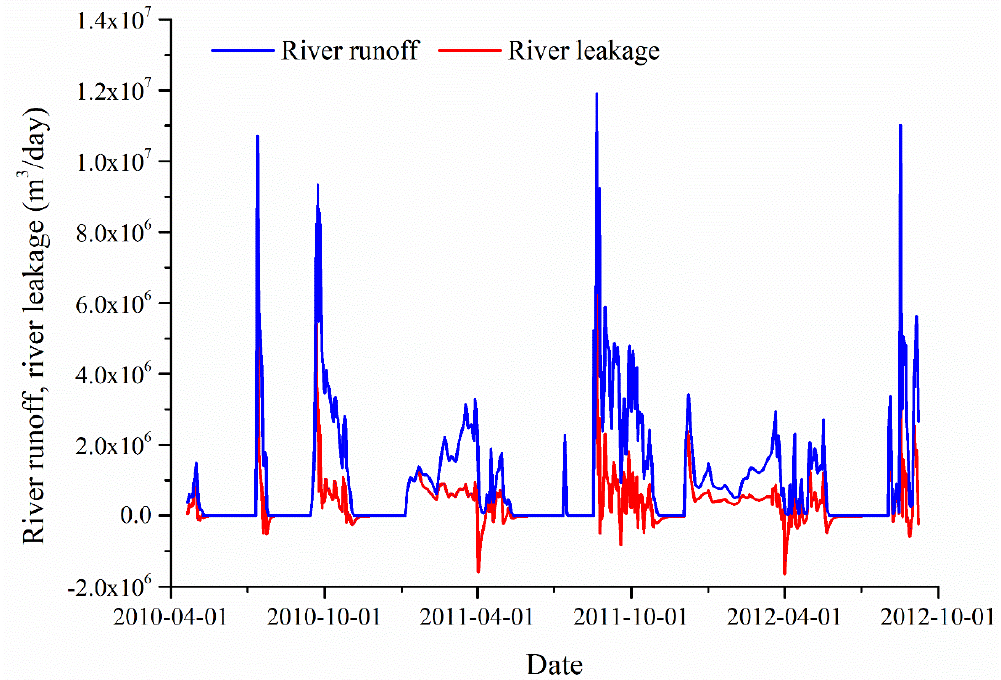
Figure 5. Observed daily runoff of the Donghe River at the LHS and simulated daily river leakage from 21 April 2010 to 7 September from 21 April 2010 to 7 September 2012.